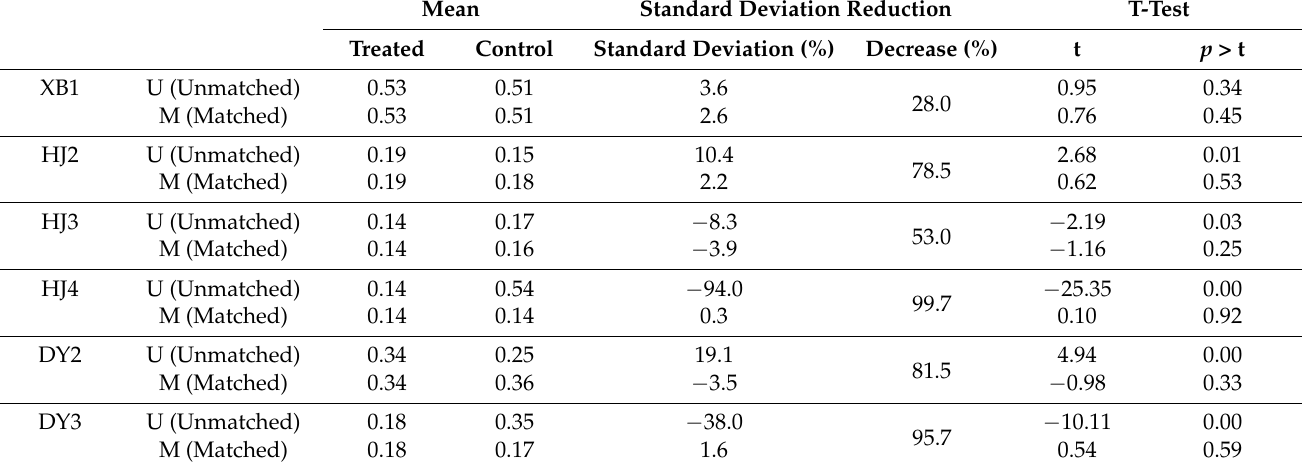
Table 9. Balance test of covariates in propensity-score matching (using fifth graders as an example).